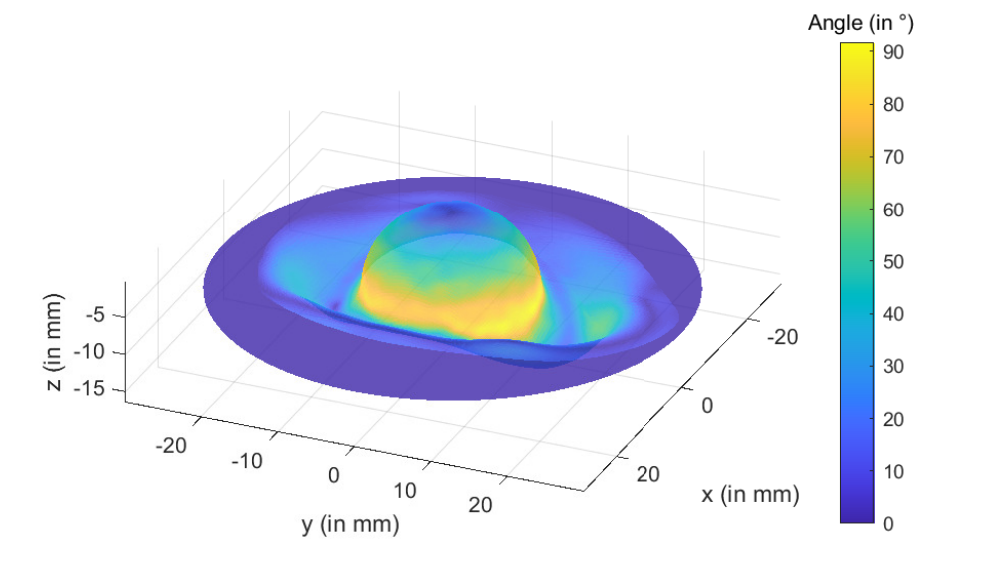
Figure 6. Analyzed part’s angle variation. Formability, surface finish, thickness variation, processing time, and dimensional accuracy are all affected by the tool path in SPIF processes. The digital control provides the tool route (CNC). The tool follows a succession of contour lines with a vertical increment step size of ∆ z = 0.2 mm between them in a single forming step. The punch had a diameter of 2.5 mm. With a diameter of 100 mm and a thickness of 1 mm, the titanium alloy sheet was modeled into a round shape. The portion was created along the tool’s trajectory, as shown in Figure